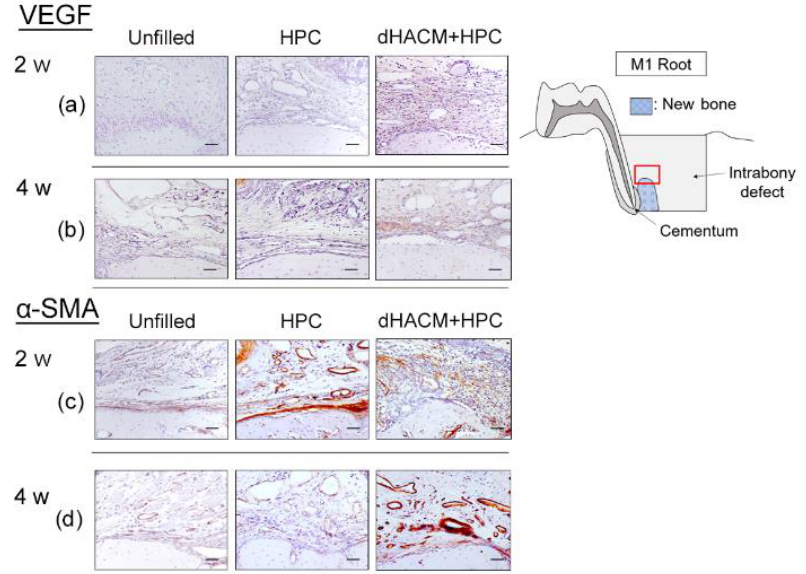
Figure 5. Representative photomicrographs of immunohistochemical staining for VEGF and α -SMA. VEGF-stained images at 2 weeks ( a ) and 4 weeks ( b ). A brown coloration indicates VEGF-positive reaction. The prevalence of VEGF-positive cells in the dHACM+HPC group appears to be greater than that in the Unfilled group. α -SMA-stained images at 2 weeks ( c ) and 4 weeks ( d ). The prevalence of α -SMA-positive blood vessels appears to be higher in the dHACM+HPC group compared with the Unfilled group (VEGF and α -SMA counterstaining with Mayer’s haematoxylin stain, original magnification × 200; bar = 50 µ m). Table 1. Quantitative analysis of VEGF and α -SMA immunohistochemical images. Group